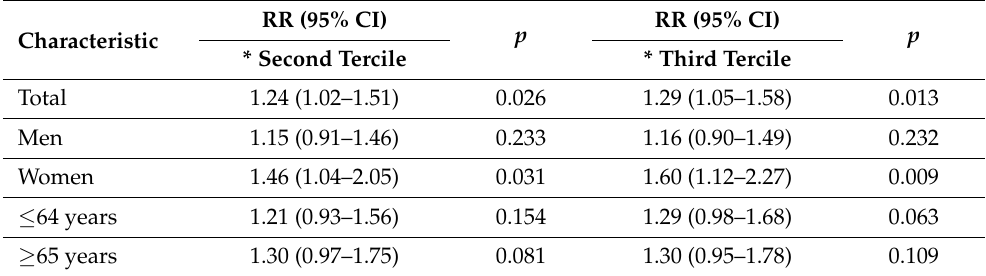
Table 6. RR with 95% CI in terciles of mean concentration of PM 10 during 5–11 days before during the period of 23 January–12 May, additionally adjusting for NO 2